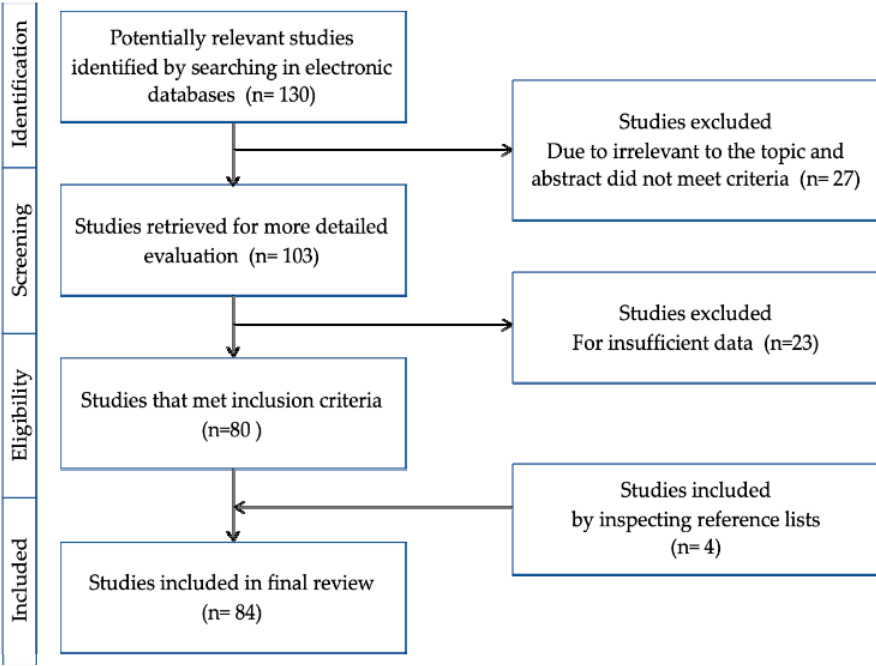
Figure 1. Methodology conducted.